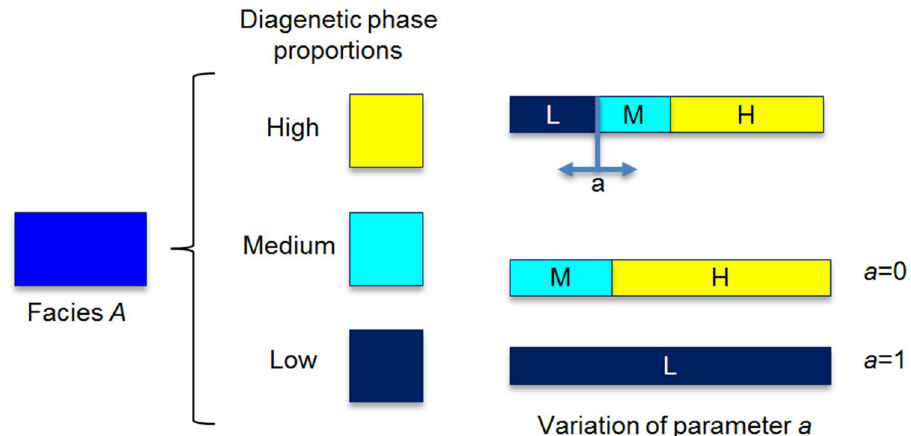
Fig. 7 Example illustrating the impact of parameter a . Param- eter a controls the proportions of the level of low occurrence of the targeted diagenetic phase in facies A